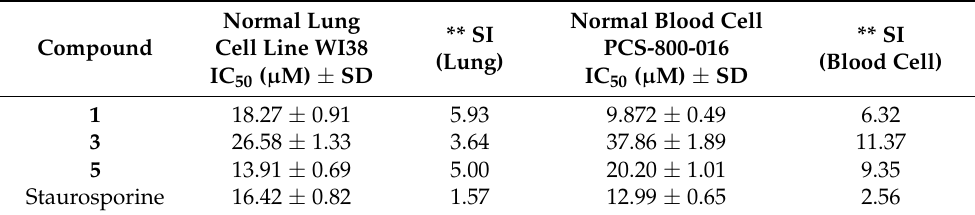
Table 2. Cytotoxicity and selectivity index (SI) of 1 , 3 , and 5 using normal lung cell WI38 and normal blood cell PCS-800-016 in